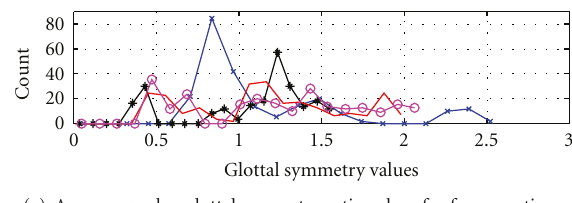
Figure 3: Glottal symmetry value distributions for (a) a male speaker, (b) a female speaker, and (c) average for ten male and ten female speakers, for angry ( x ), happy ( ∗ ), sad (+) emotions, and neutral ( ◦